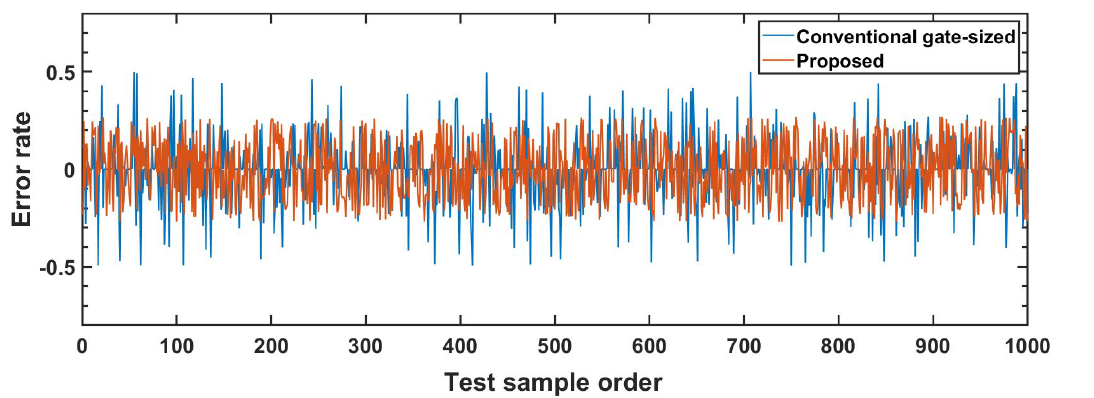
Figure 10. The error rate comparisons between the gate-sized conventional and proposed design with 0.9 V supply voltage using 1000 test